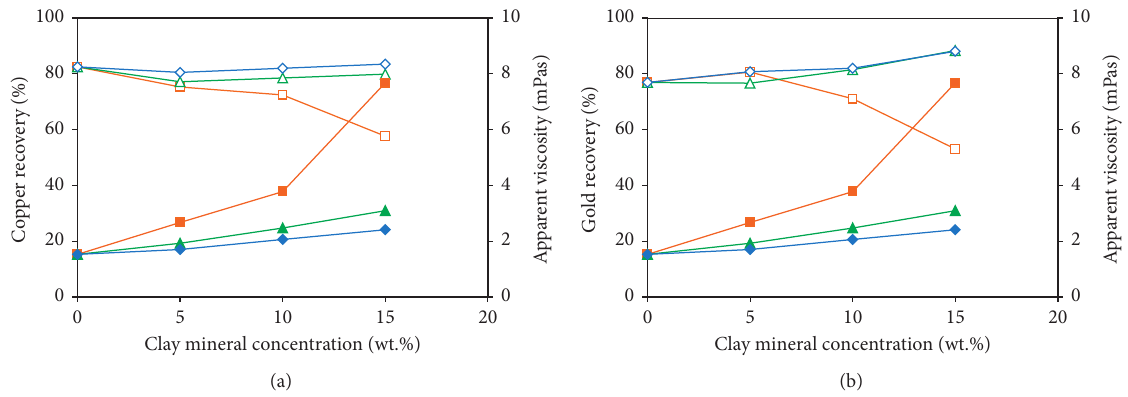
Figure 9: Effect of clay minerals on (a) copper recovery and (b) gold recovery (hollow points) and apparent viscosity (solid points) of flotation slurries: Snobrite ( ◊ ); Q38 ( △ ); and bentonite ( □ ) (after